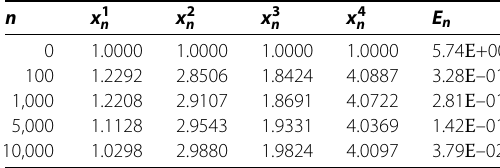
Table 1 Numerical results as regards Example 1